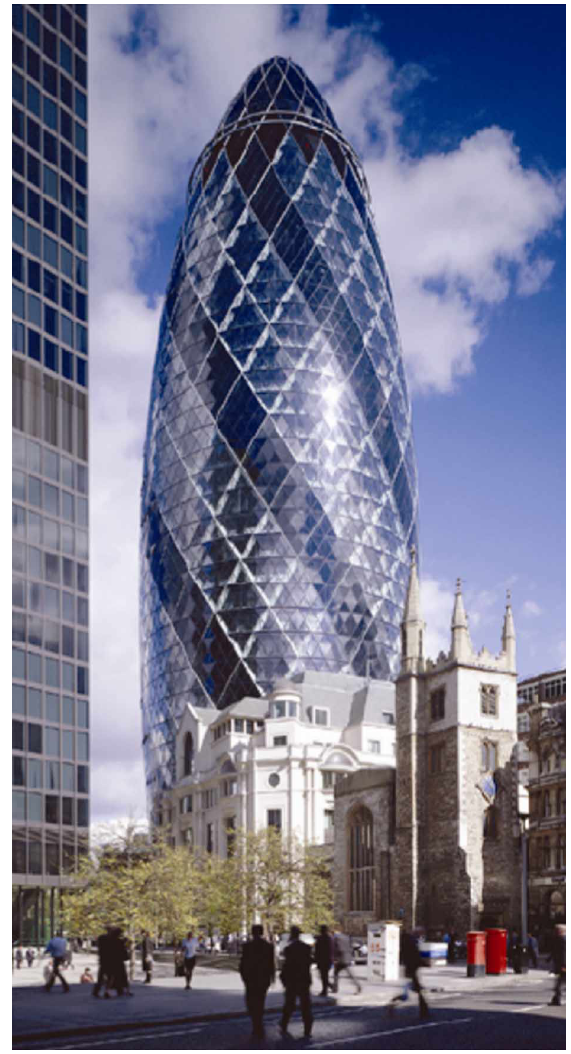
Fig. 2. The use of LSB system in CCTV Headquarters, Beijing (Leonard 2007)